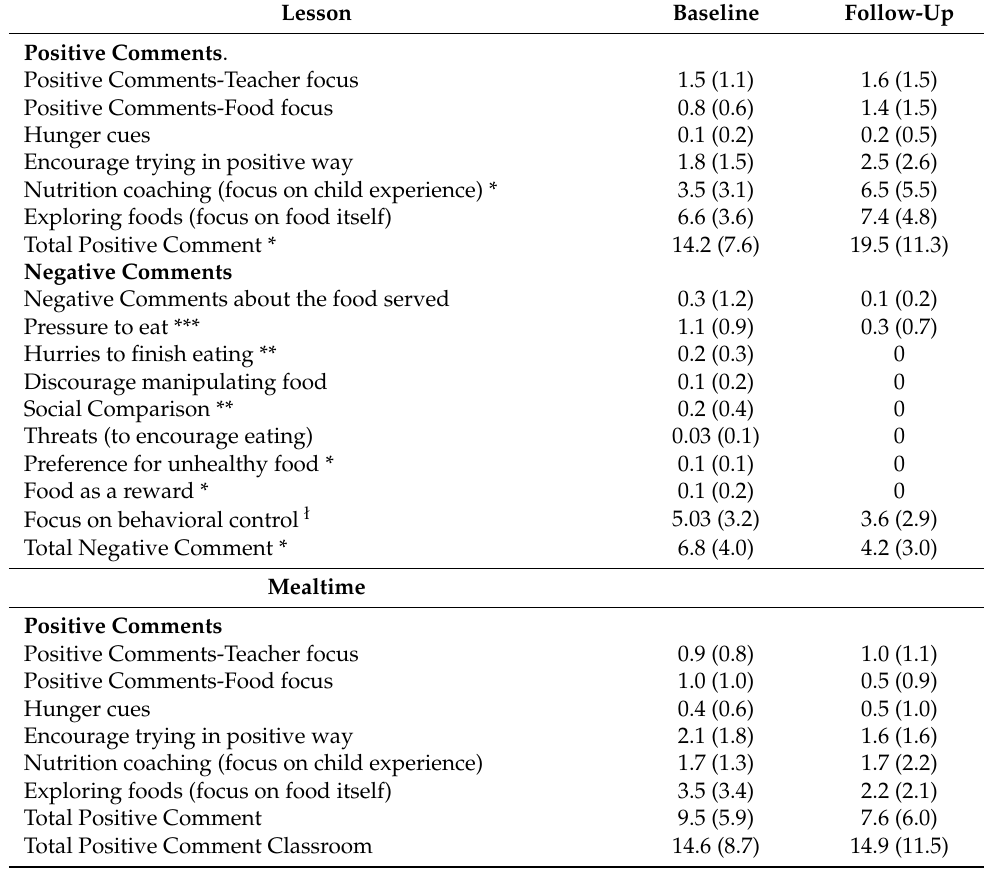
Table 4. Within-group table talk comments for de-implementation + enhanced